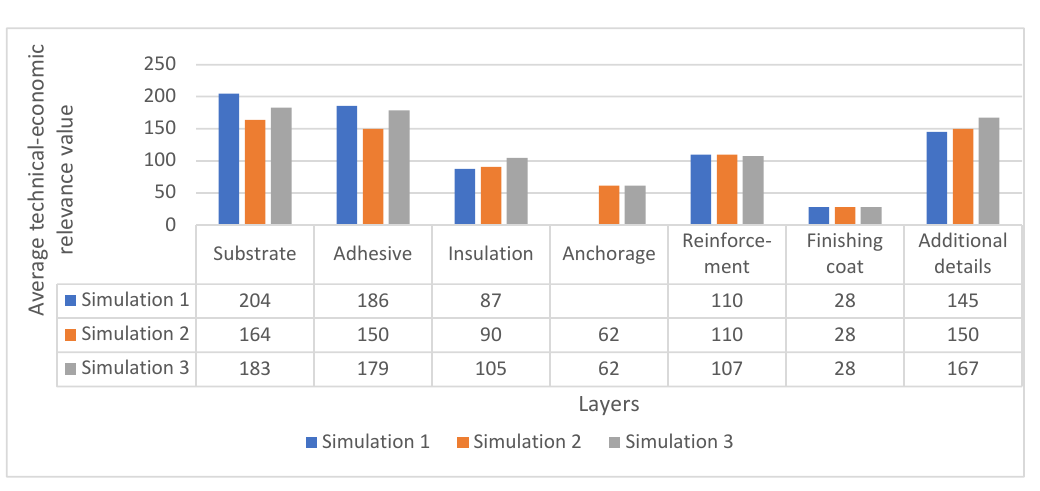
Figure 8. Average technical–economic relevance (TER) value of the simulations by layers.